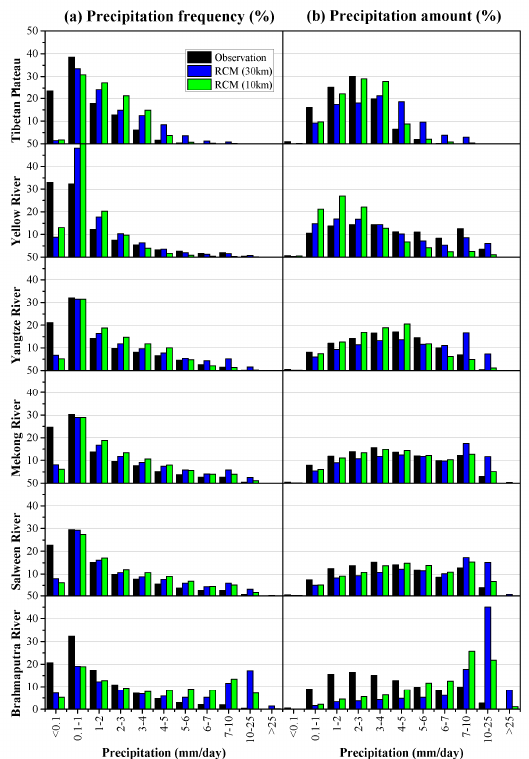
Figure 9. The distribution of frequency ( a , left panel ) and amount ( b , right panel ) for simulated daily area-averaged precipitation and observation over the whole TP and five basins (from top to bottom) during 1980 − 2010.